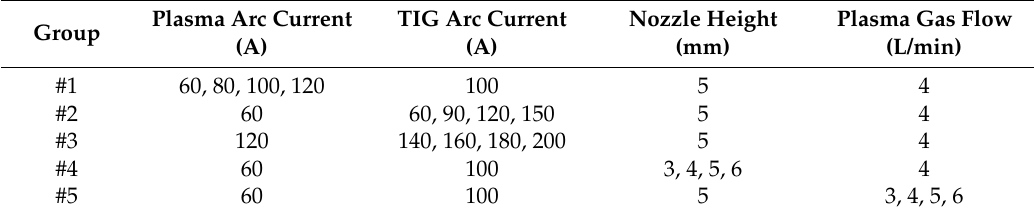
Table 1. Welding parameters for designed experiments.